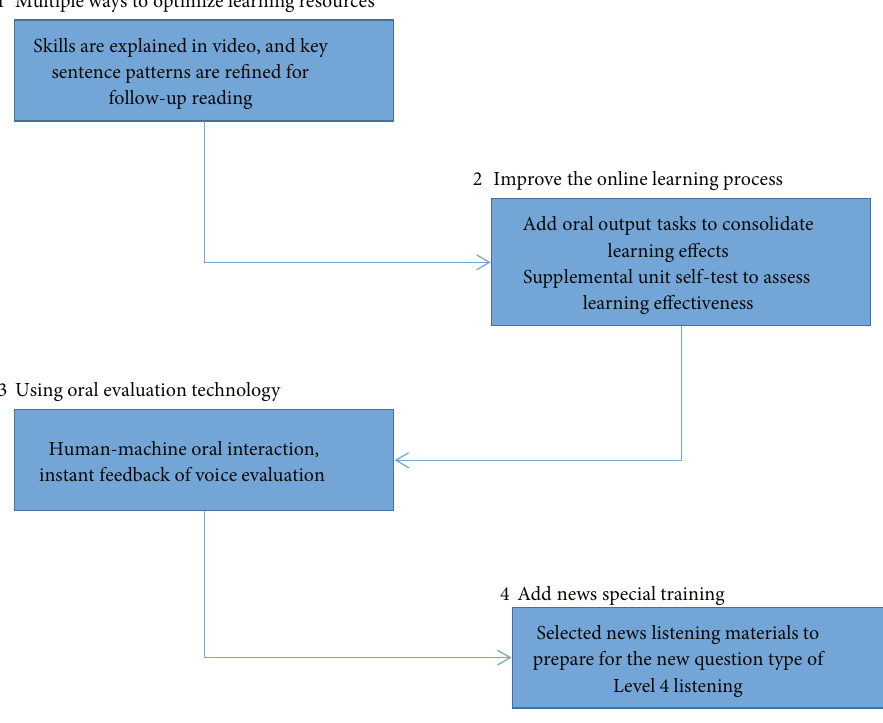
Figure 7: Example of oral English teaching framework designed based on BOPPPS model.